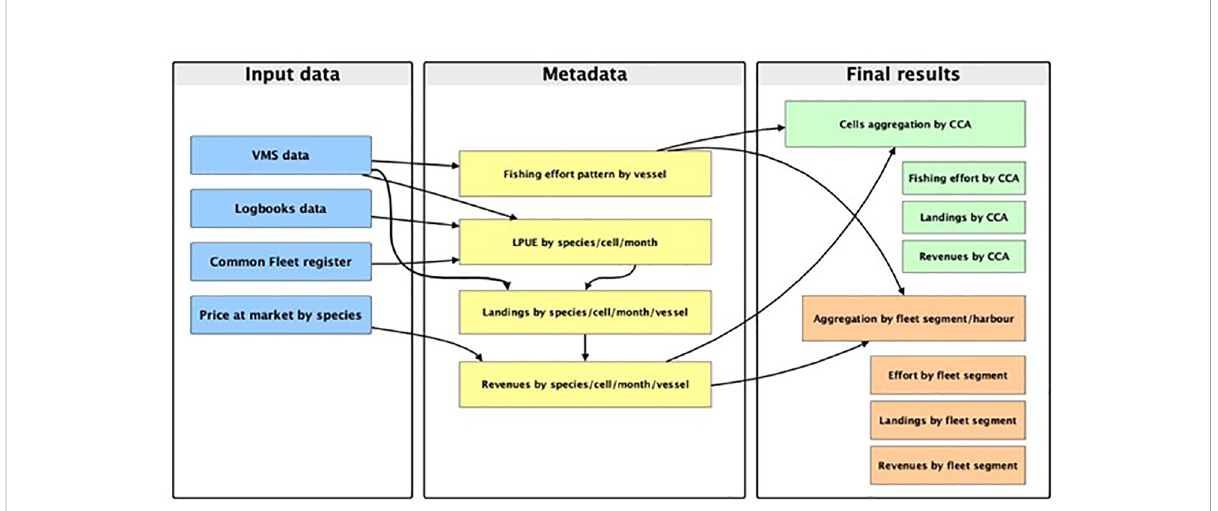
FIGURE 2 Diagram of the work fl ow, from input data to fi nal output, applied in this study to assess the value of CCAs for the trawl fi sheries operating in the area of